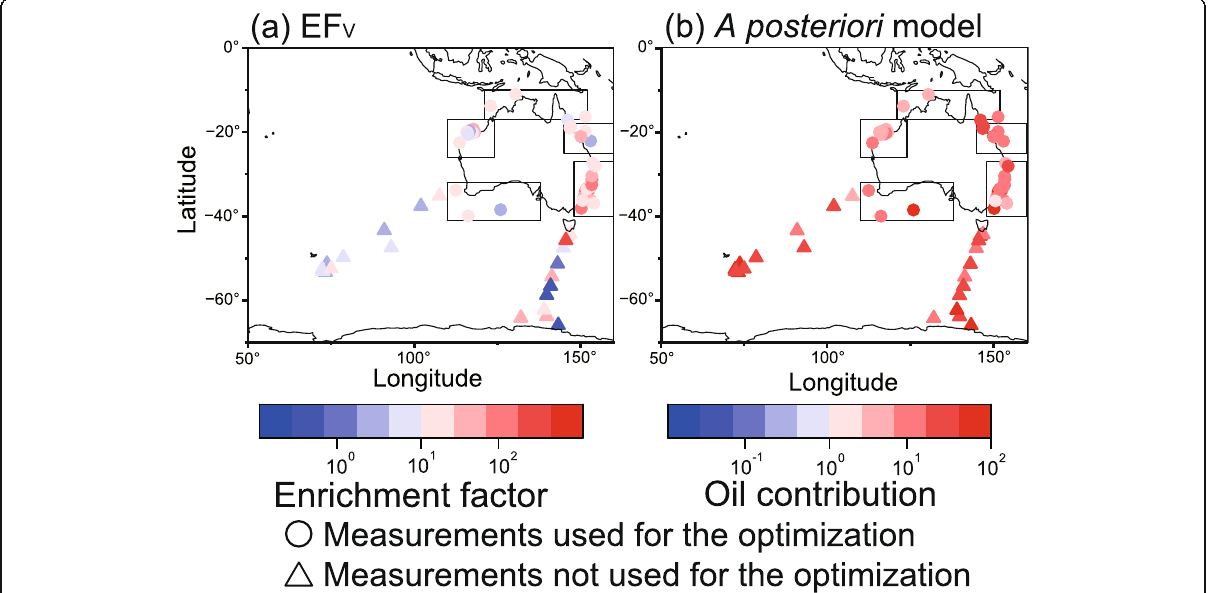
Fig. 8 Variability in a enrichment factor in vanadium (EF V ) and b a posteriori model contribution of oil combustion sources to L Fe (%) in each sampled aerosol (or associated geographical grid